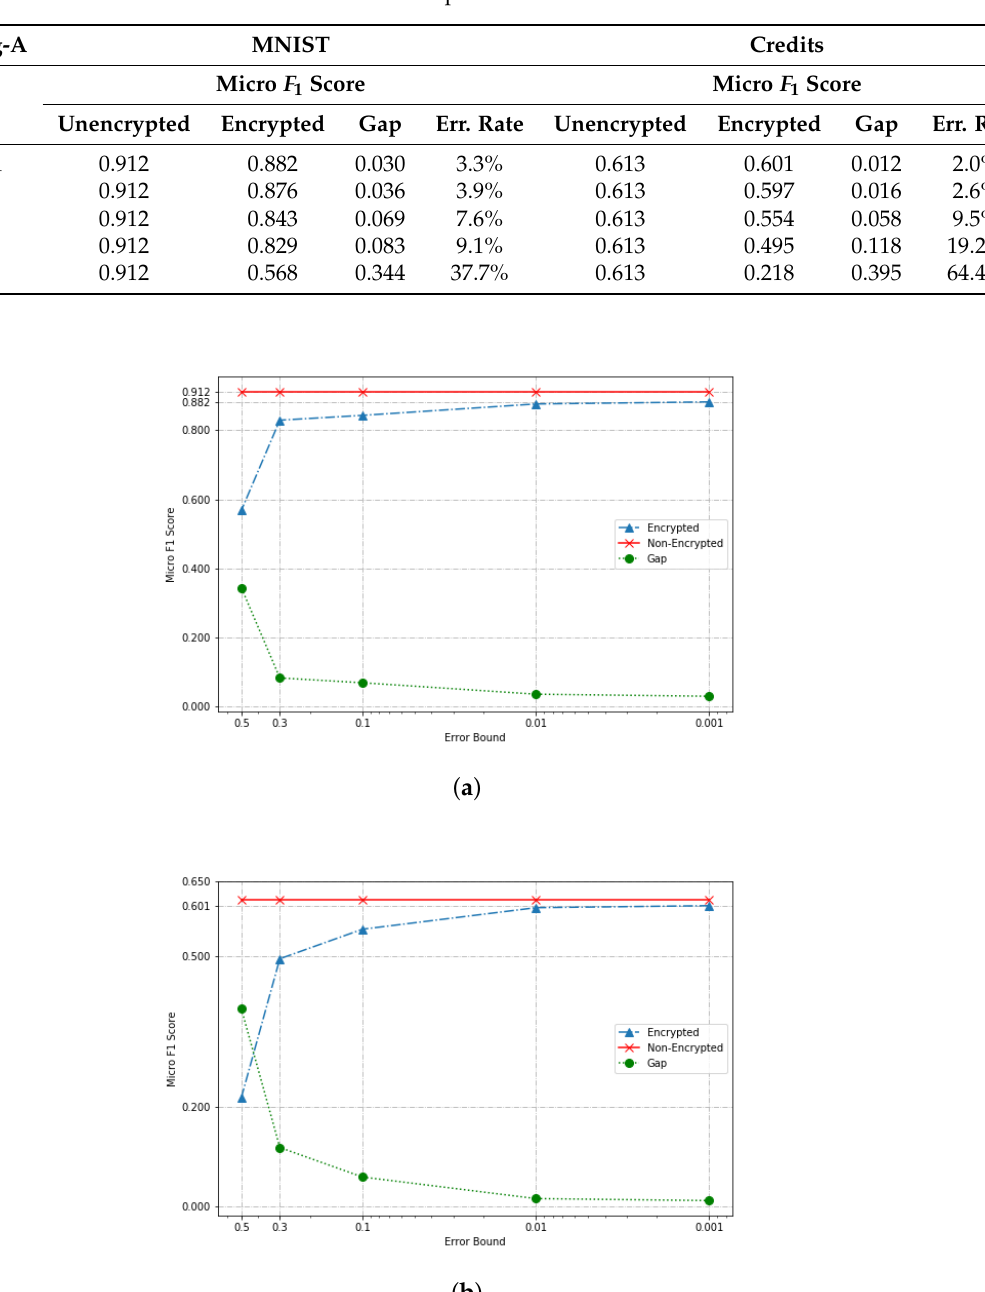
Figure 6. Performance comparison between non-encrypted and encrypted mode. ( a ) Performance on the MNIST dataset; ( b ) performance on the Credit